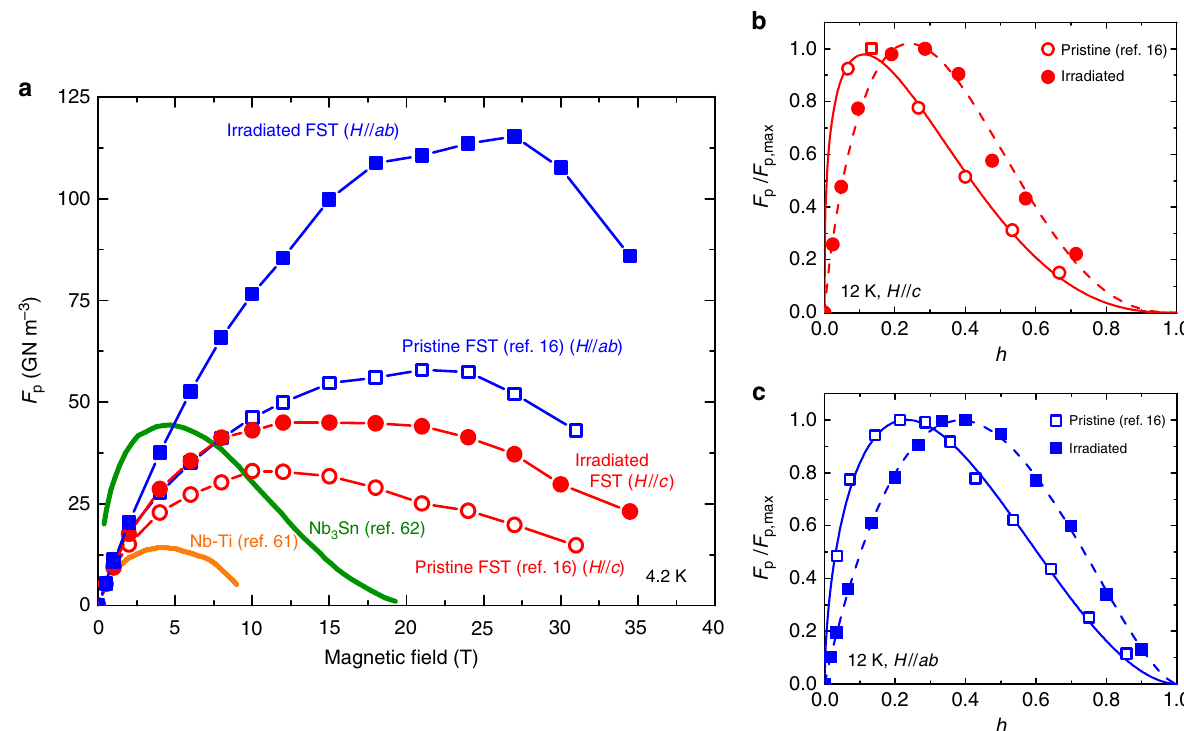
Figure 7 | High-field pinning force. ( a ) F p ( H ) for FST film before and after 190keV proton irradiation with 1 (cid:2) 10 15 pcm (cid:3) 2 dose at 4.2K, compared with NbTi (ref. 61) and Nb 3 Sn (ref. 62) wires. ( b , c ) Normalized F p ( h ) for FST film before (open symbols) and after (close symbols) proton irradiation at 12K for H // c and H // ab , respectively, whereas solid (before) and dashed (after) lines are the corresponding fitting